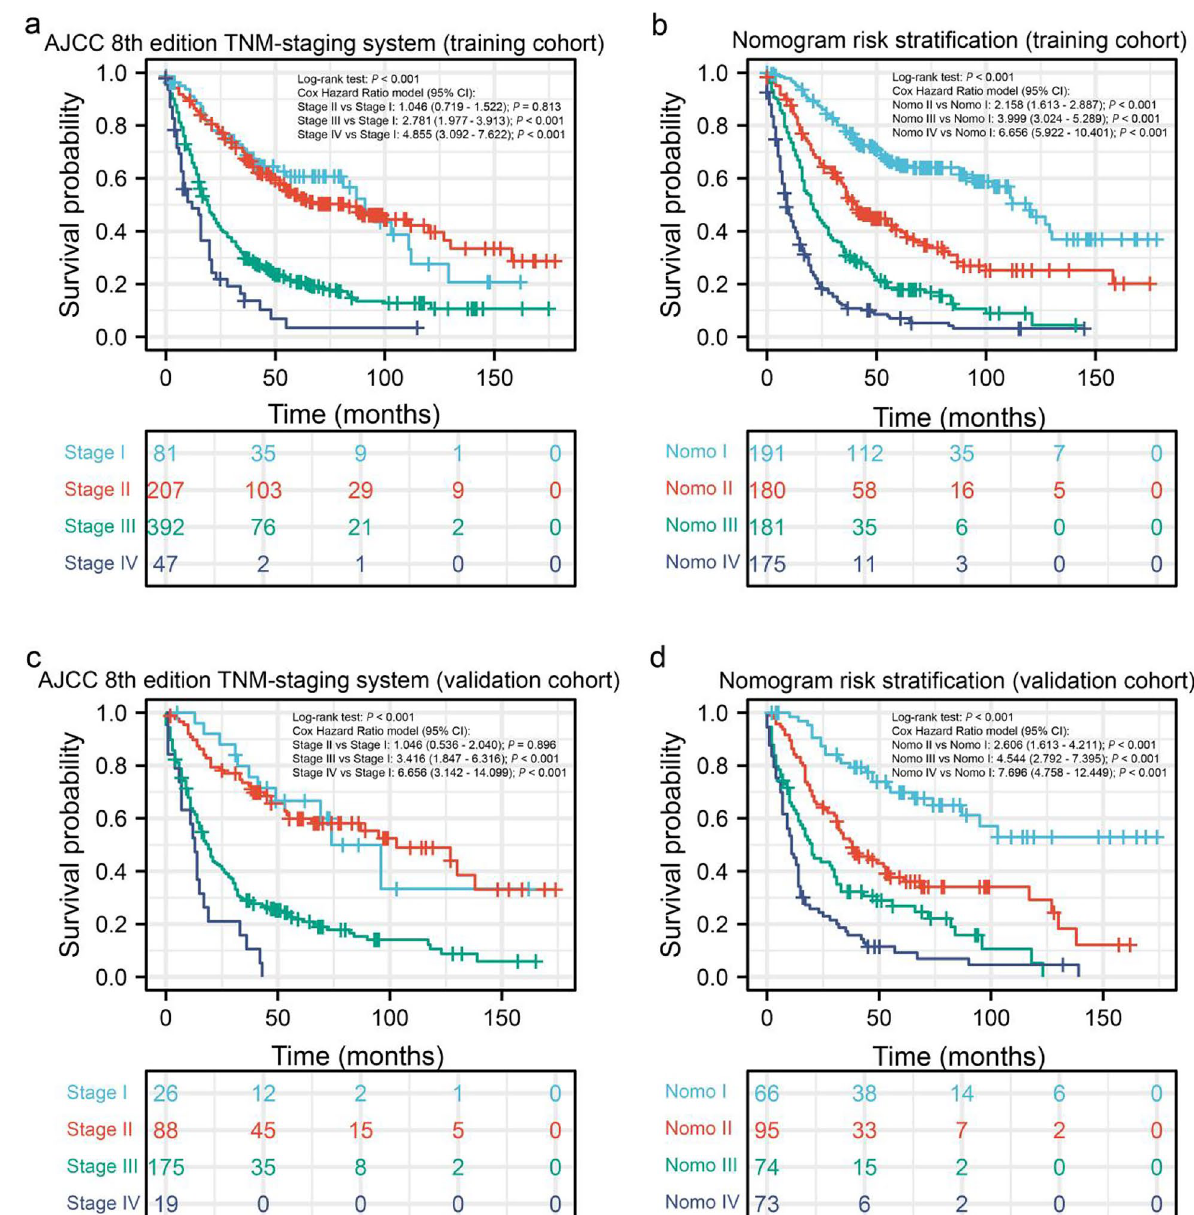
Figure 4. Kaplan–Meier overall survival curves of patients with NM-GBA at different stages or with different risks stratified by the nomogram. ( a ) NM-GBA patients in the training cohort at different stages were classified according to the AJCC 8th edition TNM-staging system. ( b ) NM-GBA patients in the training cohort at different risks were stratified according to the nomogram. ( c ) NM-GBA patients in the validation cohort at different stages were classified according to the AJCC 8th edition TNM-staging system. ( d ) NM-GBA patients in the validation cohort at different stages were stratified according to the nomogram. NM-GBA non-metastatic gallbladder adenocarcinoma; AJCC American Joint Committee on Cancer, TNM tumor, node,